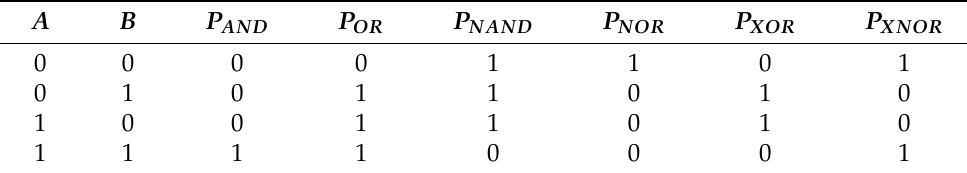
Table 1. The truth table of six kinds of binary logic